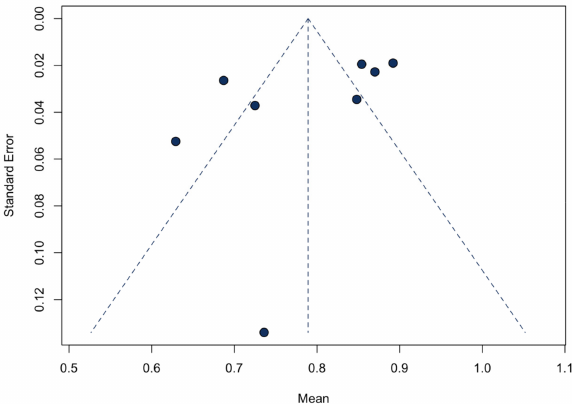
Figure 5. Funnel plot of the included studies demonstrating atrioventricular